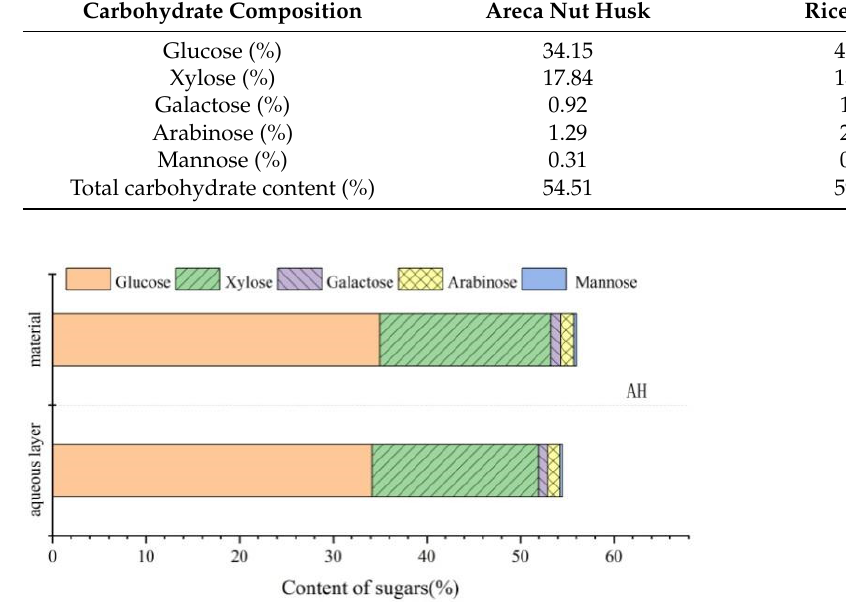
Figure 10. Analysis of carbohydrate content of areca nut husk before and after phase separation.